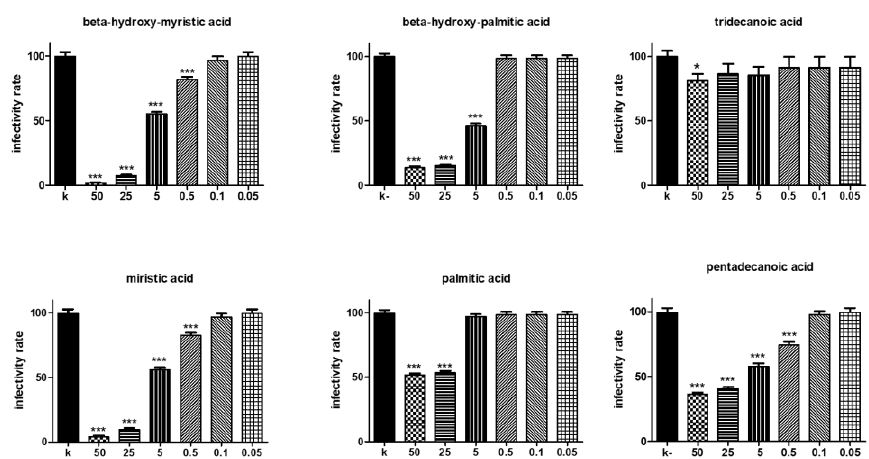
Figure 2. Anti-chlamydial effect of selected fatty acids. Experiments were performed with differ- ent concentrations of fatty acids (final concentrations ranging from 50 to 0.05 µg/mL) added to 5 × 10 3 EBs at 60-min time point. Chlamydial infectivity was evaluated as IFU/field and expressed as % of control (K) (5 × 10 3 EBs incubated in PBS), taken as 100%. Bars represent mean values, error bars represent SEM. *** p < 0.0001.